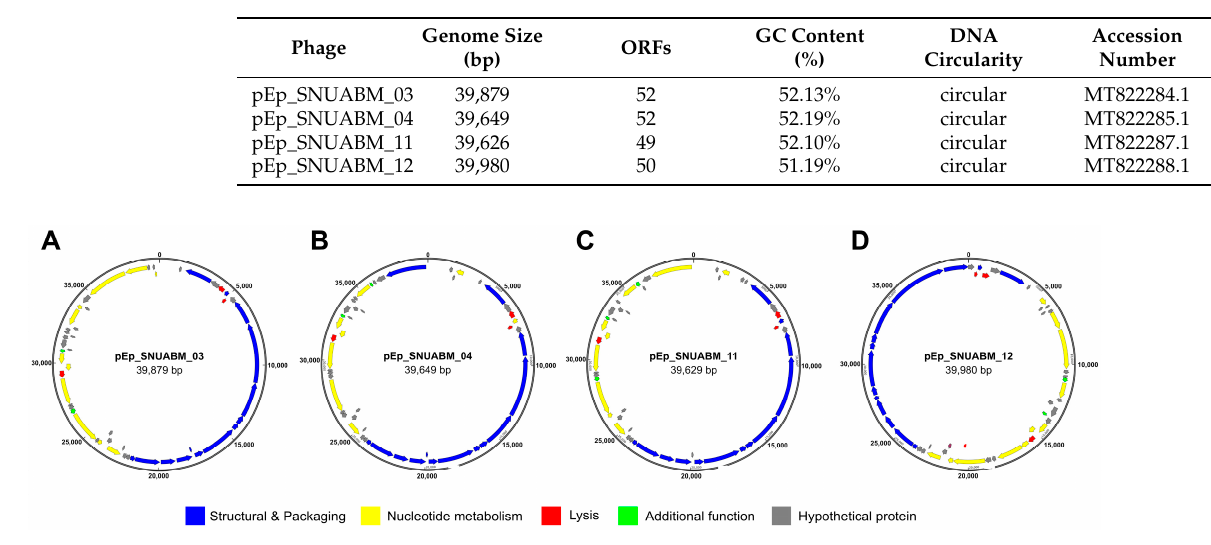
Table 2. General genomic features of Erwinia phages.